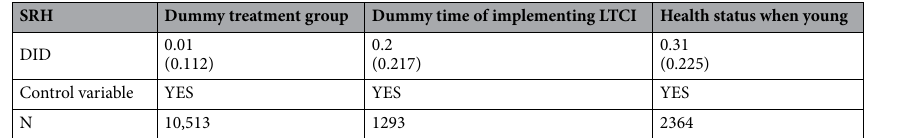
Table 4. Sensitivity analysis of LTCI implementation. * p < 0.10, ** p < 0.05, *** p < 0.01.